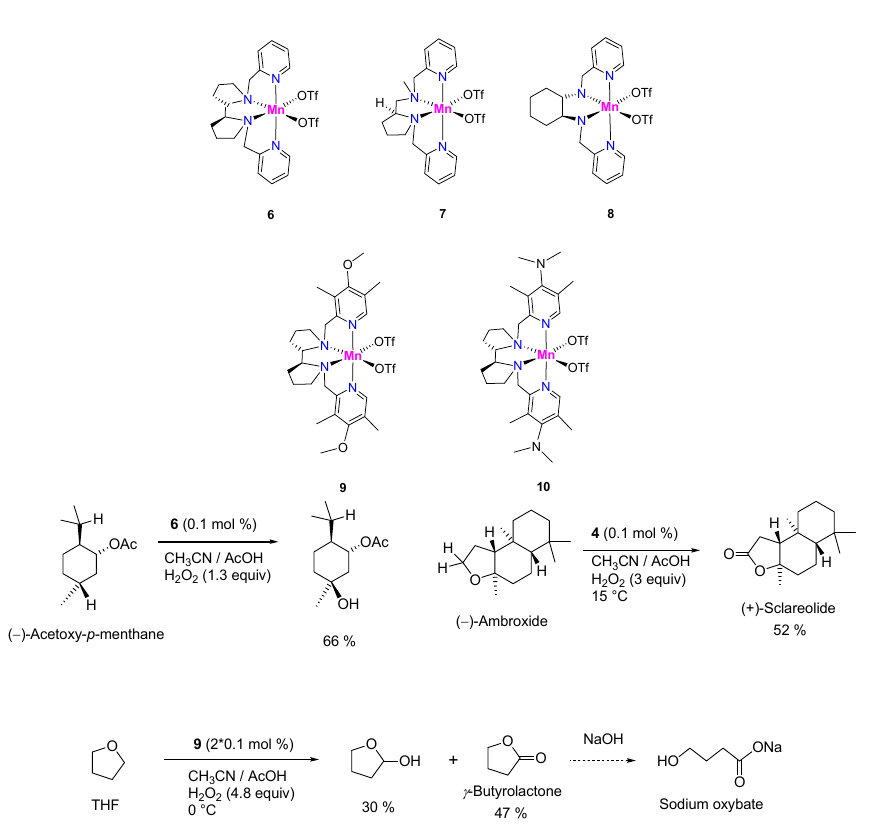
Figure 4. Examples of preparative ‐ scale selective C–H oxidations catalyzed by Mn ‐ aminopyridine complexes.